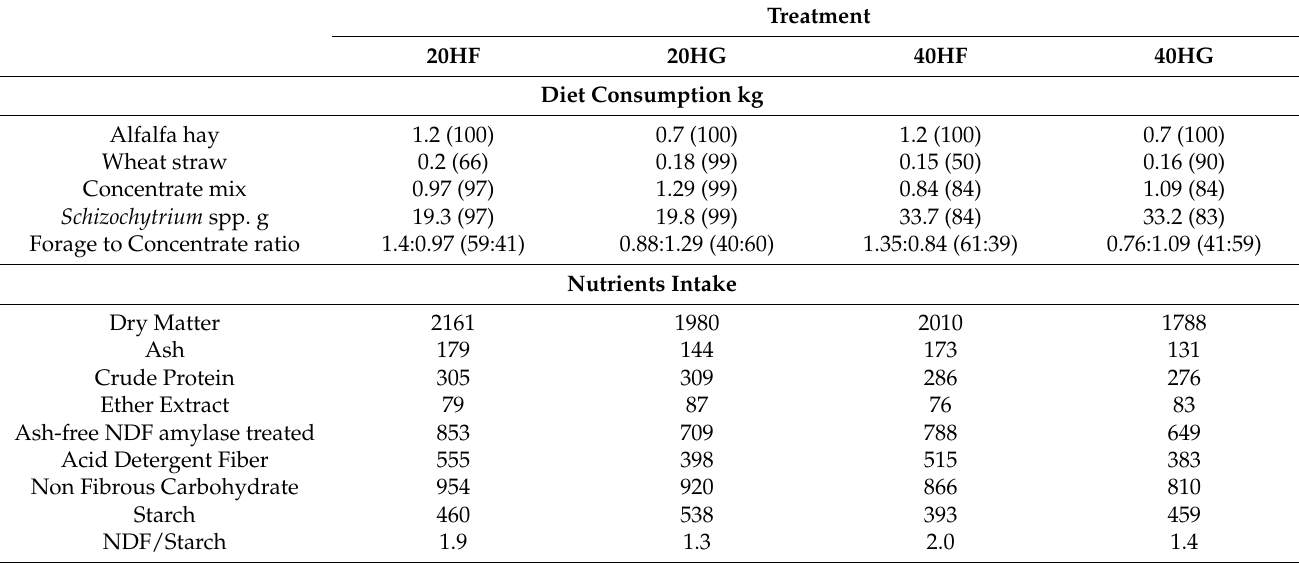
Table 4. Feed intake on a fresh matter basis (Kg/goat and percentage of consumed quantities compared to given) and nutrients consumption (g) of the four groups (20HF, 20HG, 40HF, and 40HG) of goats involved in the trials.